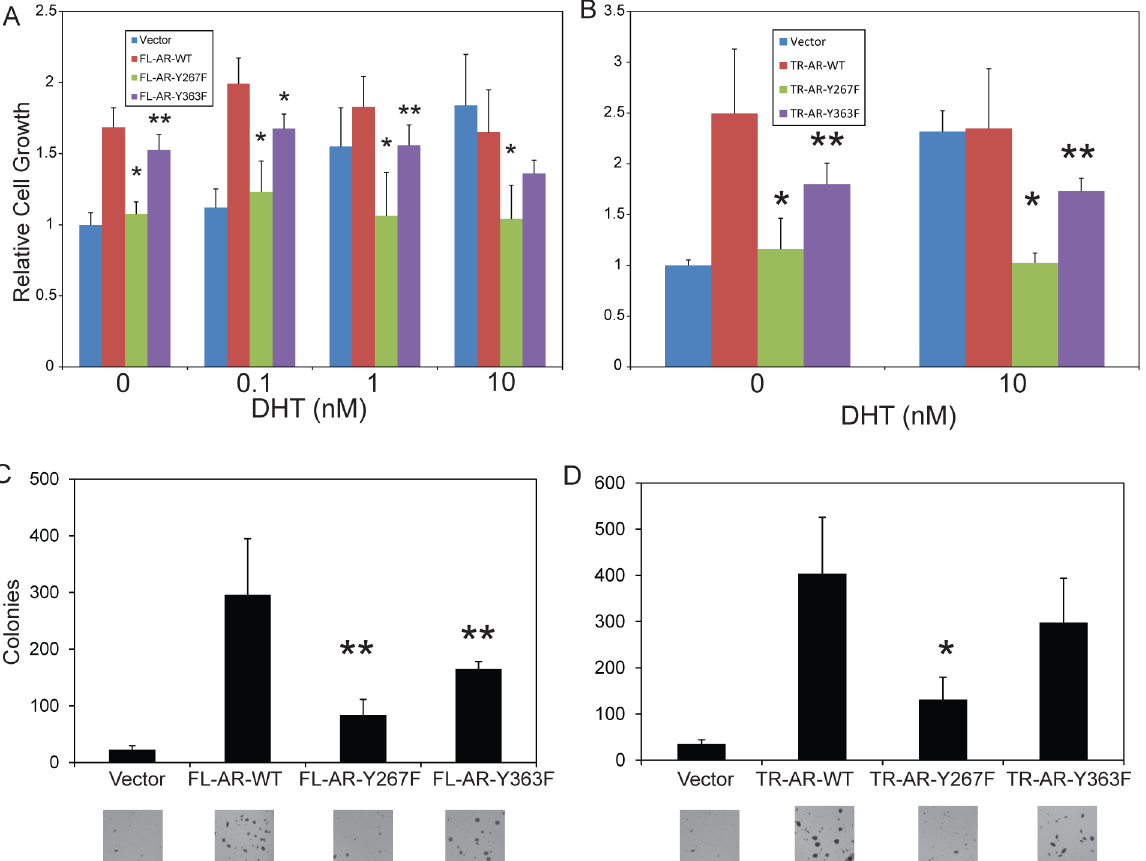
Fig 4. Phosphorylation site mutants of AR are defective in stimulating cell proliferation and anchorage-independent soft agar colony growth. (A, B) LNCaP cells stably overexpressing full length AR (A) or truncated AR (B) were grown in a 96-well plate for 72 hours in media with charcoal-stripped serum and 0, 0.1, 1, or 10 nM of DHT, as indicated. Absorbance at 450 nm was measured after incubation with the colorimetric dye WST-8 for 4 hours. Values were normalized to vector control cells treated with 0 nM DHT. Data shown are the mean + standard deviation of three independent experiments, each performed with triplicate or quadruplicate wells. * , p < 0.001 vs AR-WT; ** , p < 0.05 vs AR-WT by two-group t-test adjusted using the Bonferroni method. (C, D) Cells stably overexpressing full length AR (C) or truncated AR (D) were plated in soft agar and incubated for 3 weeks. Colonies were stained and counted. A representative view of the colonies is shown below. Data shown are the mean + standard deviation of two (C) or three (D) independent experiments with triplicate samples. * , p < 0.001 vs AR-WT; ** , p < 0.05 vs AR-WT by two-group t-test adjusted using the Bonferroni method.